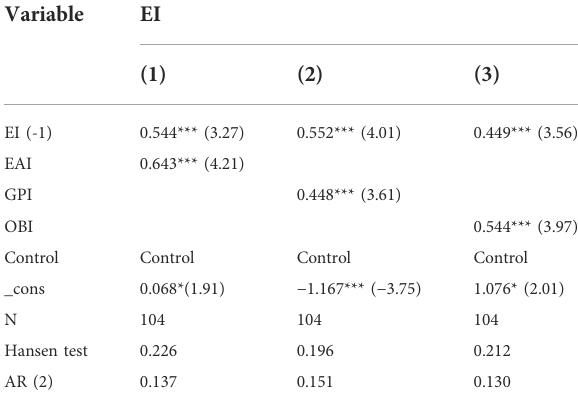
TABLE 7 Regression analysis results of the environmental impact of green agriculture development.